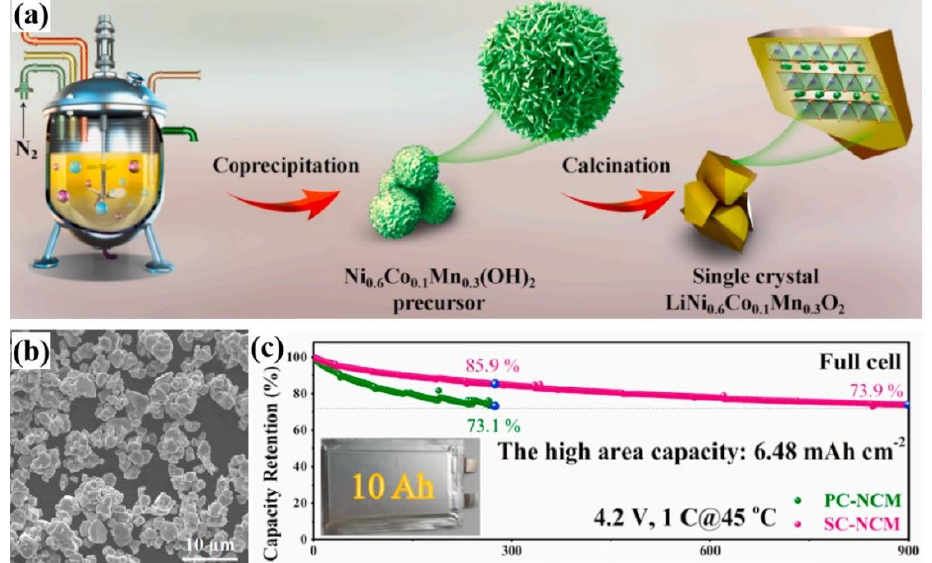
Figure 4. Research content reproduced from Ref. [248] of Xinming Fan’s group: ( a ) schematic diagram of preparation process and ( b ) SEM image for single-crystal NCM613, ( c ) the cycling performance of NCM613/graphite full cell, Copyright 2021, Elsevier.